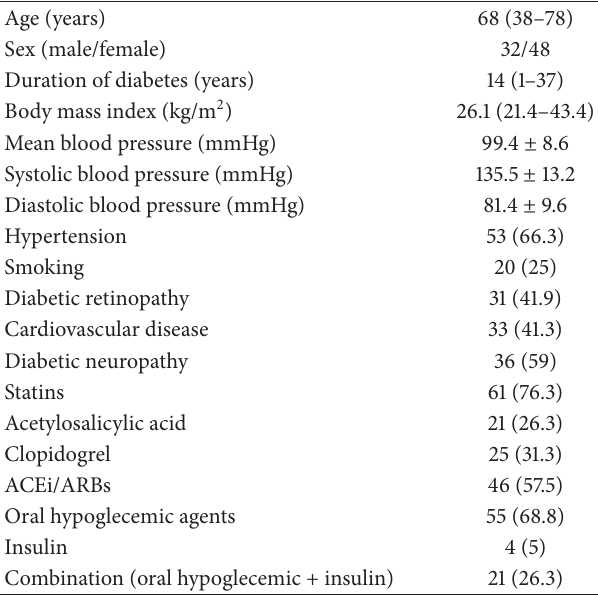
Table 1: Demographic, anthropometric, and clinical characteristics and prescribed drugs of 80 patients with diabetes mellitus type 2.